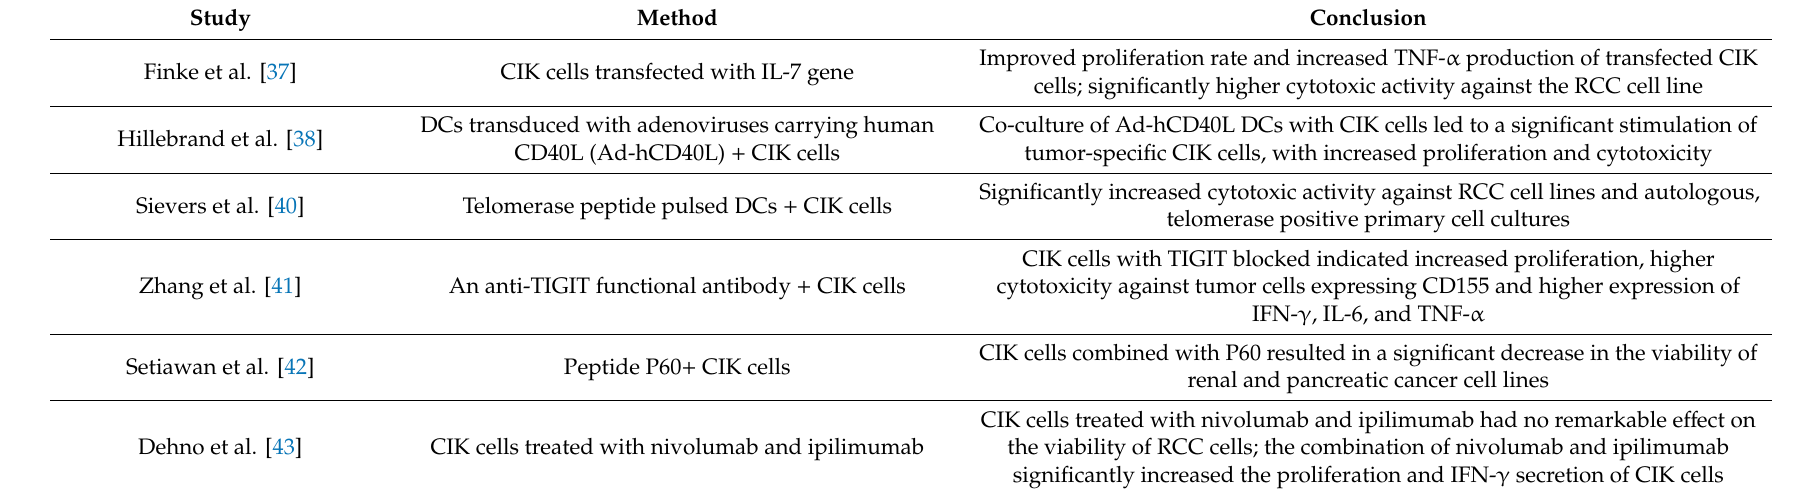
Table 2. Summary of preclinical researches conducted with CIK cells on